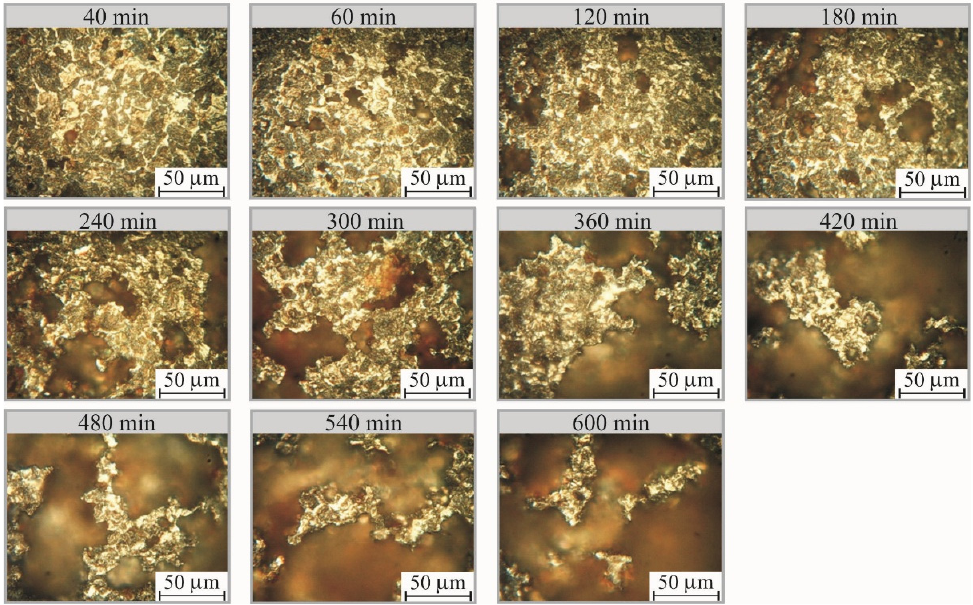
Figure 2. Dynamics of changes in the microstructure of 40Kh steel after ultrasonic treatment.